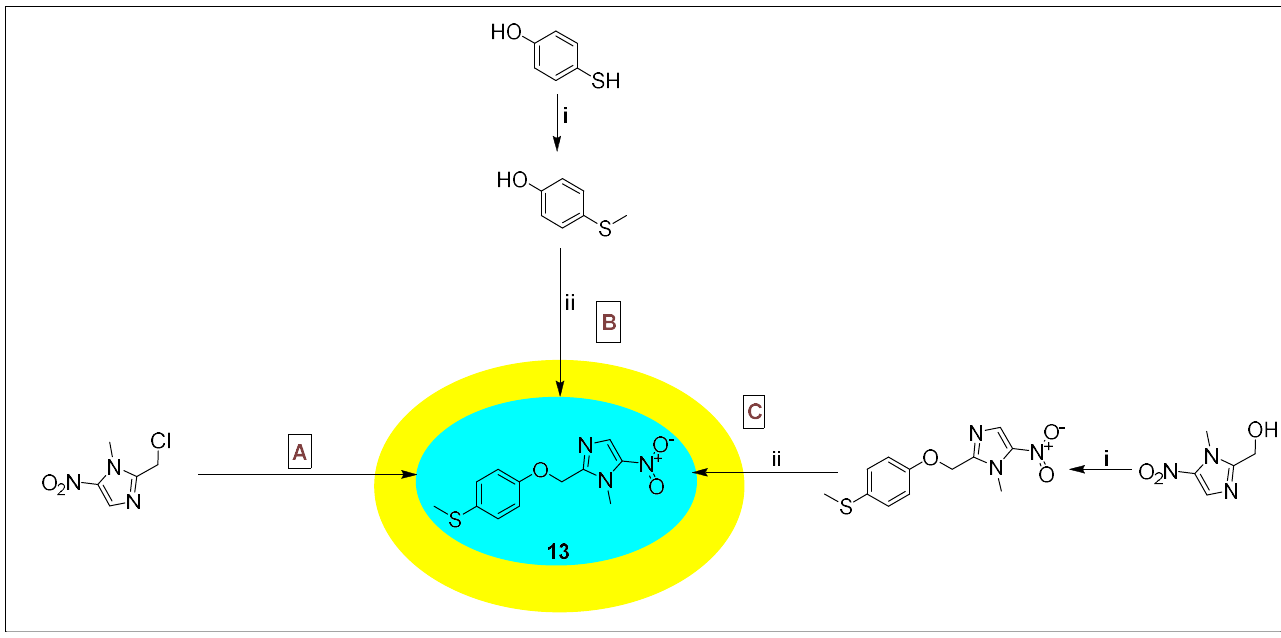
Figure 19. Activity profile of Megazol 15